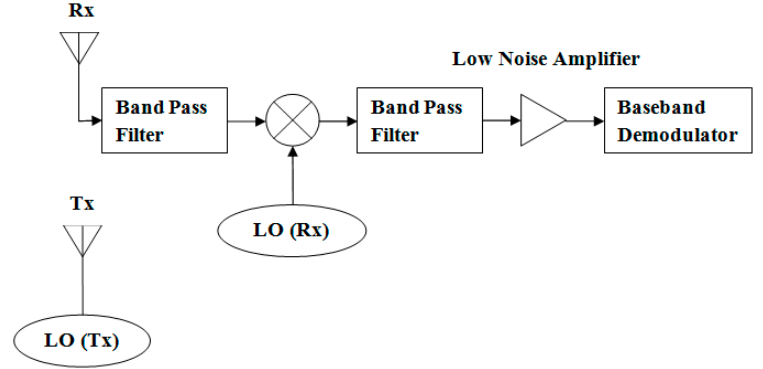
Figure 1. Heterodyne transceiver topology.